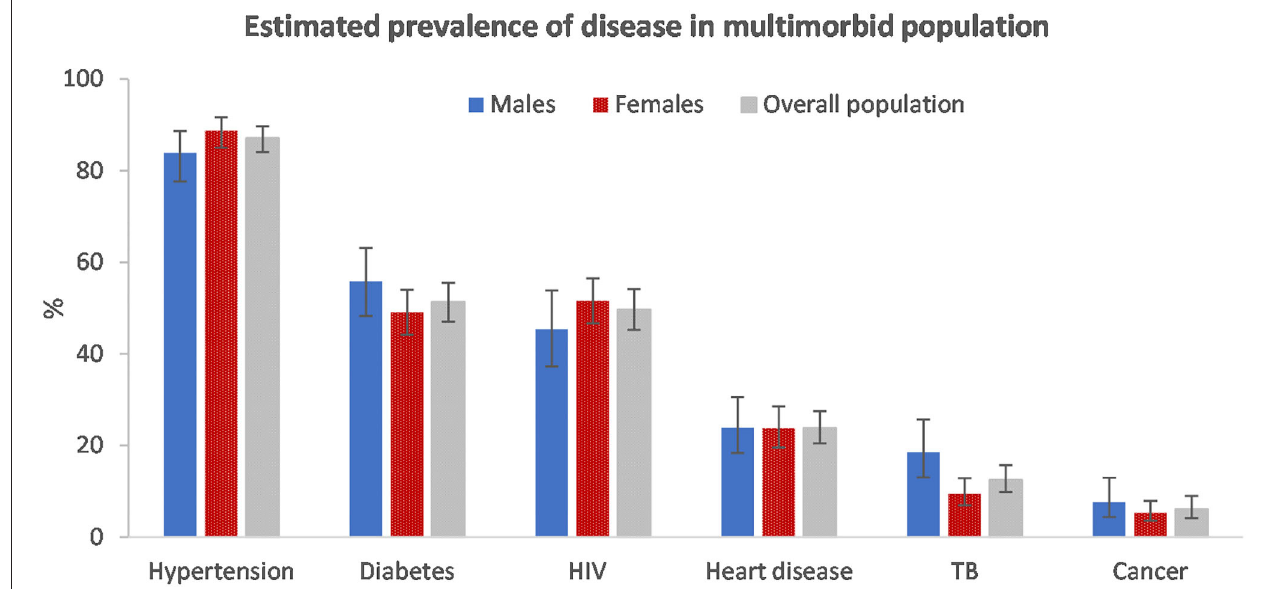
FIGURE 2 | Estimated disease prevalence in the multimorbid population by sex, South Africa 2017.